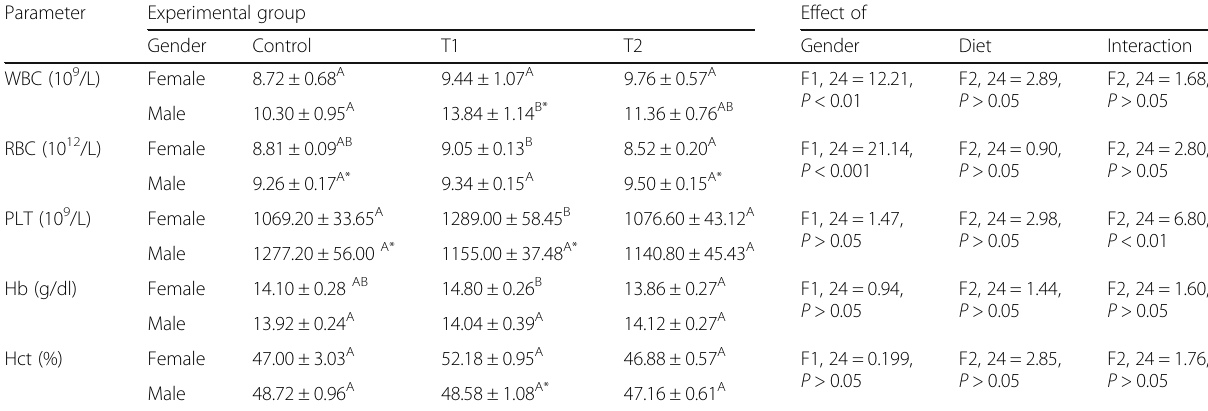
* Represents significant differences ( P <0.05) in comparison to the corresponding female groups. In each row, the mean values marked with the same superscript letter are similar (insignificant, P >0.05) whereas those with different ones are significantly differed ( P <0.05). P >0.05: insignificant, P <0.05, P <0.01 and P <0.001: significant effect at α =0.05, 0.01, and 0.001,